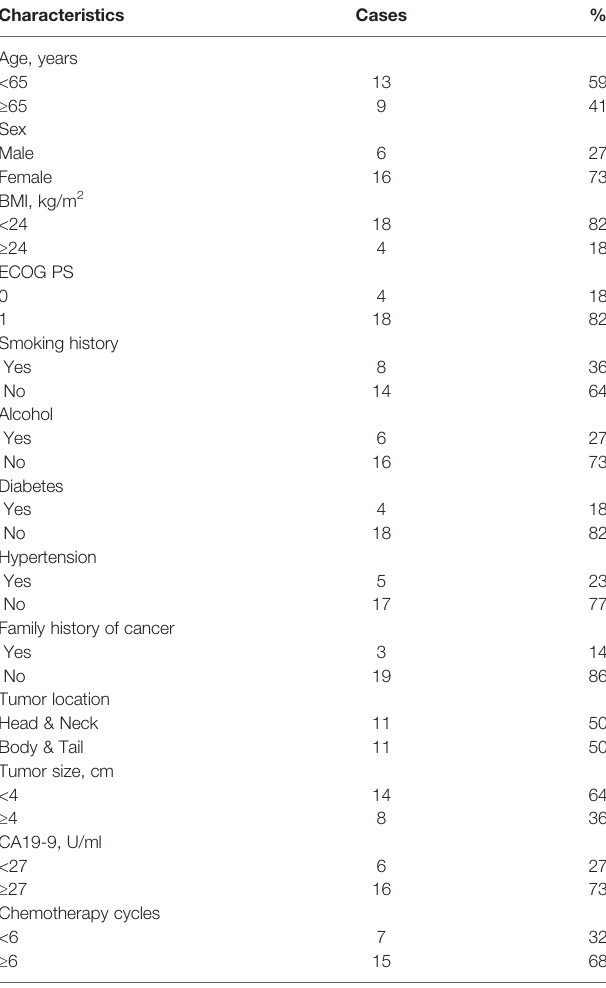
TABLE 1 | Characteristics of patients with LAPC. Characteristics